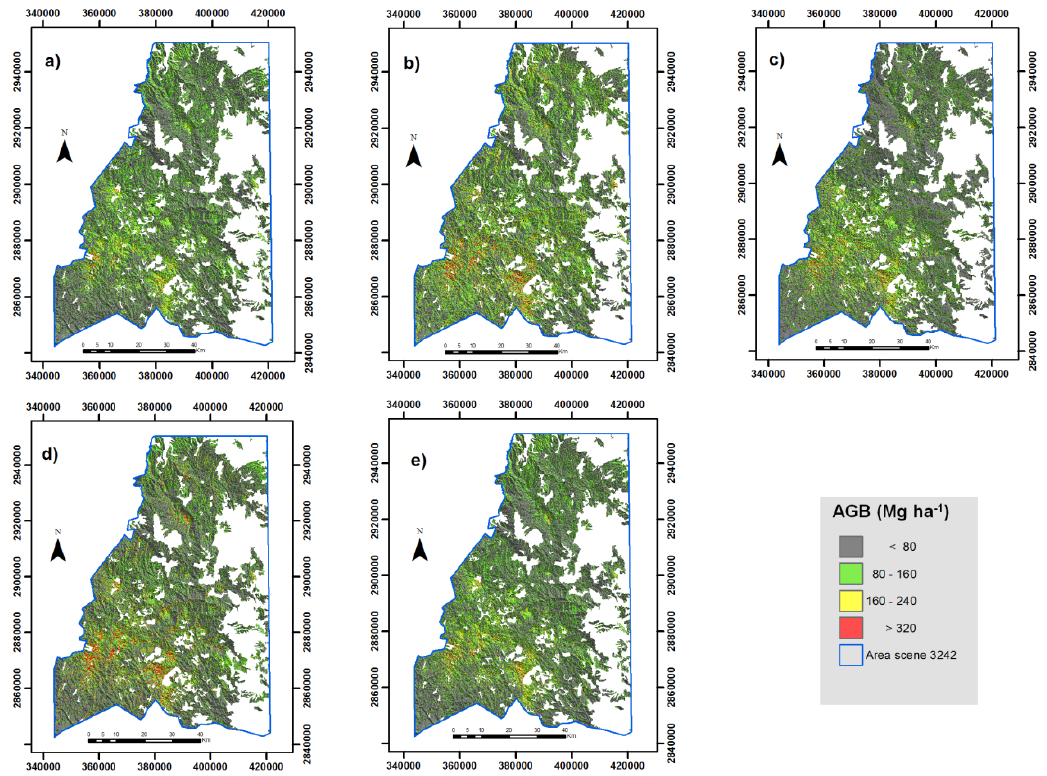
Figure 8. Maps of AGB in the study area generated from images corrected using the different radiometric correction algorithms considered. ( a ) ATCOR2; ( b ) COST; ( c ) FLAASH; ( d ) 6S; and ( e ) ToA.